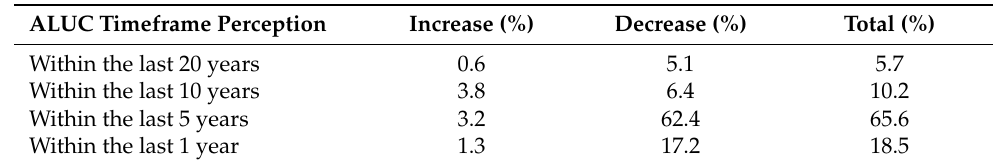
Table 2. Timeframes over which farmers (n = 157) perceived ALUC to have taken place within Benue State, Nigeria.